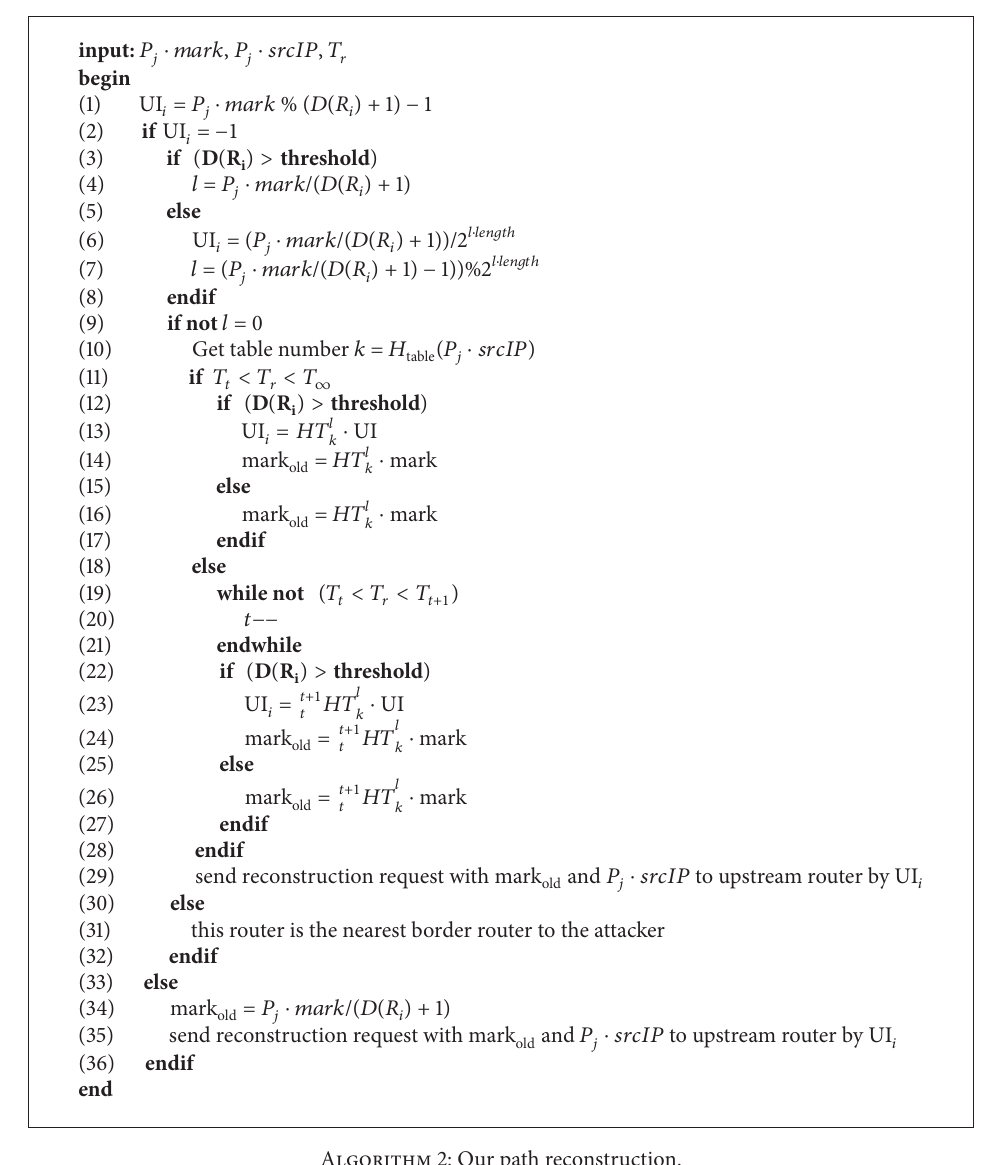
Algorithm 2: Our path